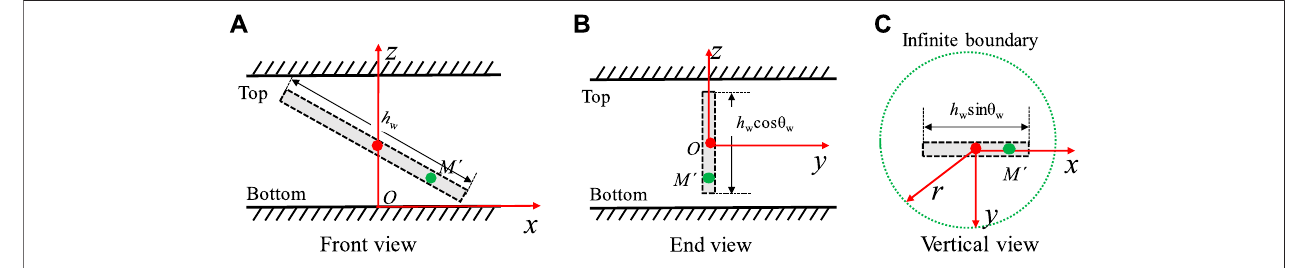
FIGURE4| Threedifferentviewin Figure 2 (Modi fi edafter Nieet al.,2012). (A) ComparisonwithGuo etal. ’ result. (B) Comparison withCamacho-Velázquezet al.